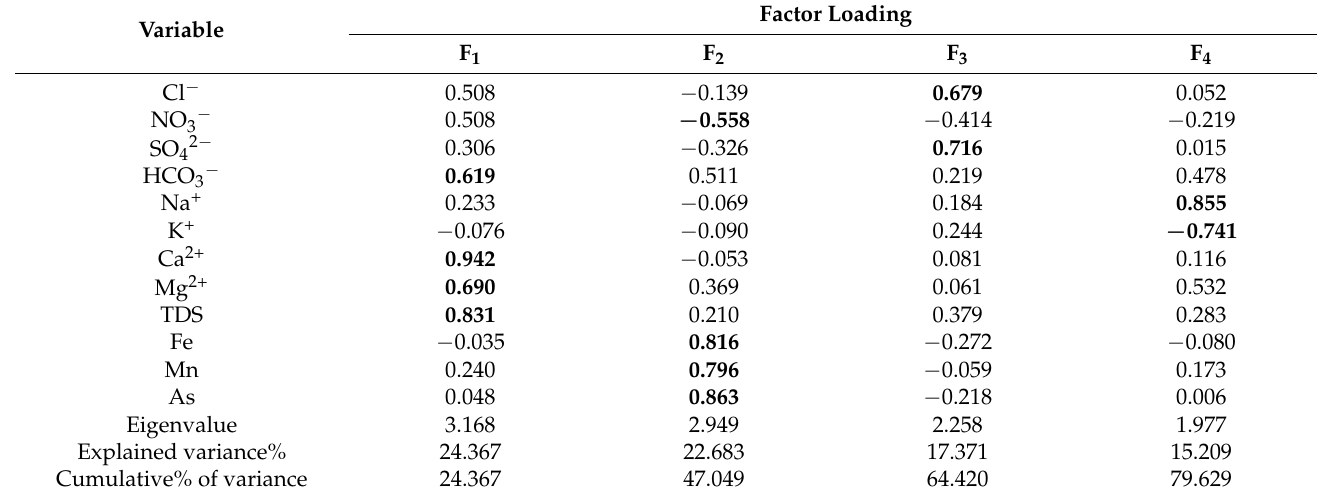
Table 4. Loading for varimax rotated factor matrix of a four-factor model explaining 79.63% of the total variance.